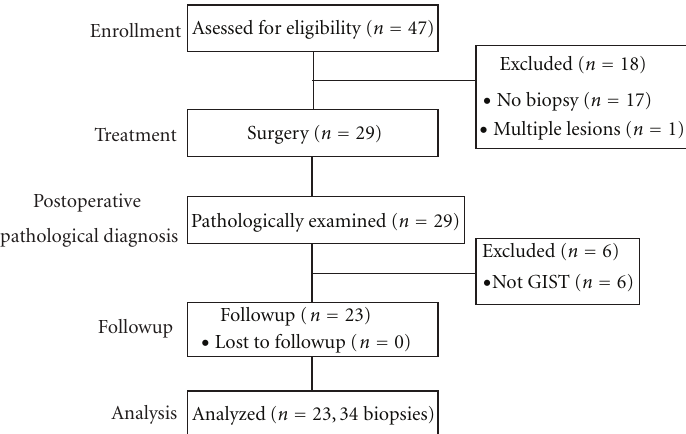
Figure 1: Enrollment of patients included in the study. Total 47 patients had undergone surgical resection for gastric submucosal tumors at the Digestive Disease Center, Showa University Northern Yokohama Hospital between April 2001 and March 2012 were retrospectively studied. The 23 patients pathologically diagnosed GIST after surgery were